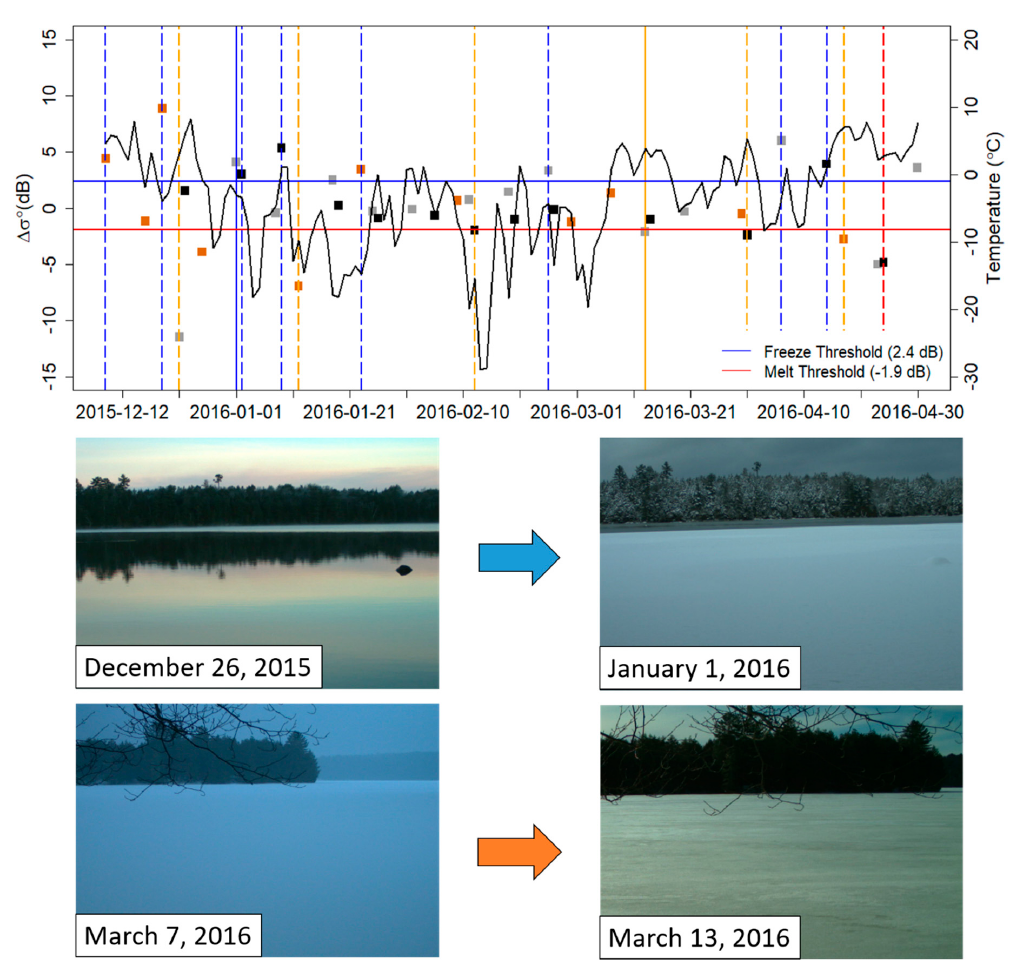
Figure 4. Mean backscatter difference ( ∆ σ ◦ , dB) evolution and temperature (black line) for MacDonald Lake during the 2016 ice season. The orange squares represent ∆ σ ◦ values where the images had similar acquisition times (AM/AM or PM/PM), the grey squares represent ∆ σ ◦ values where differences were calculated AM to PM, and the black squares represent ∆ σ ◦ values where differences were calculated from PM to AM. The blue solid line shows a freeze event identified by the threshold on 1 January 2016 associated with the camera image below. The orange solid line shows a melt event identified by the threshold on 13 March 2016 associated with the camera image below. The additional dotted lines (blue for freeze events, orange for melt events, and red for WCI) represent the multiple events captured for this lake during the 2015/2016 ice season.